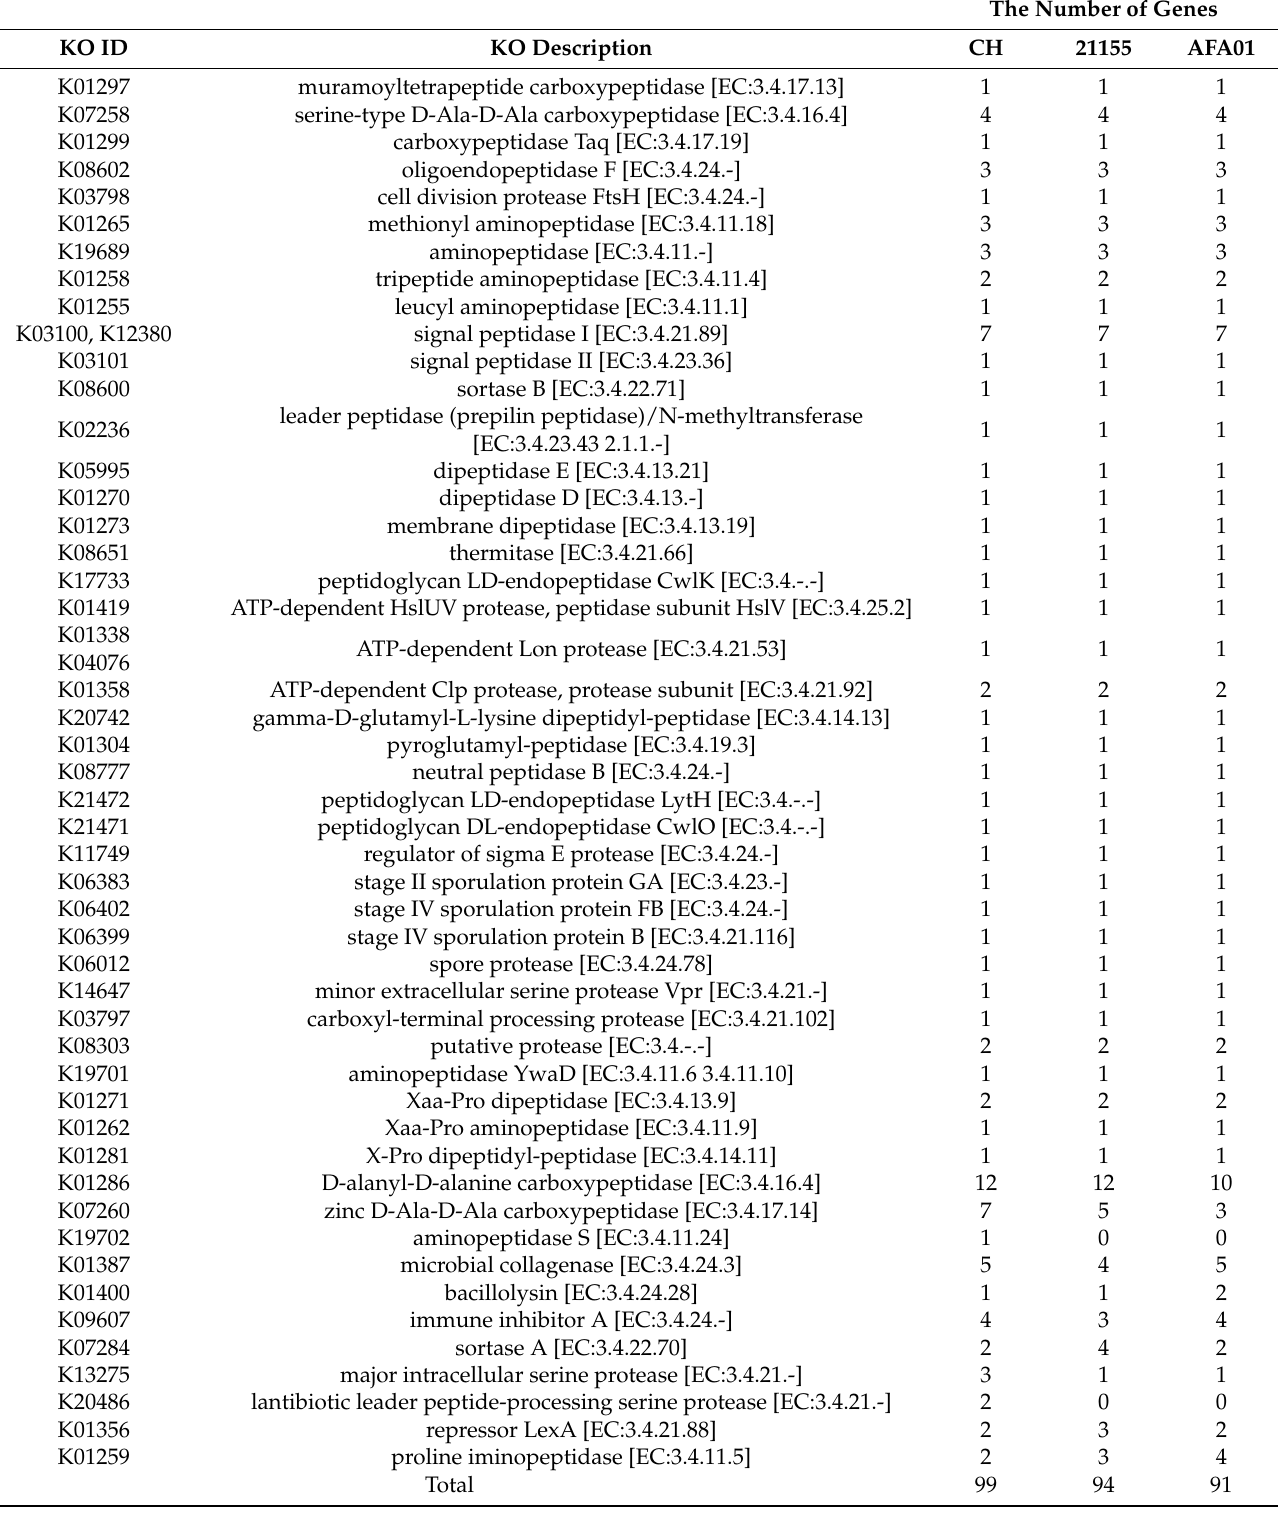
The Number of Genes